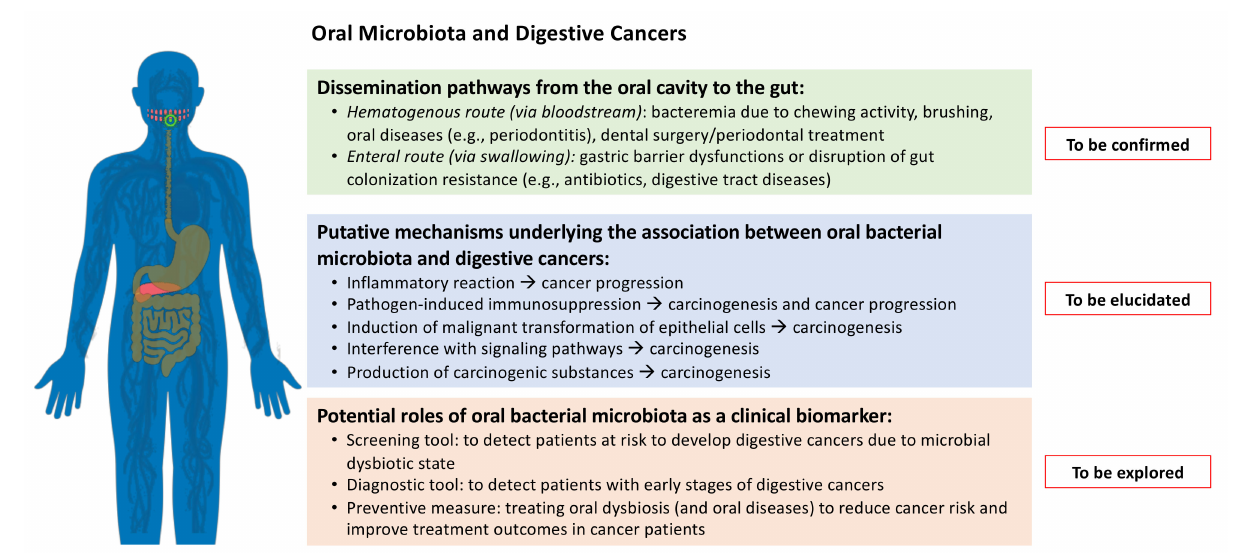
Figure 2. Schematic representation of the possible routes of oral bacteria transmigration from the oral cavity to the gut and the possible oral microbiota mechanisms in digestive cancers. The potential role of oral bacterial microbiota characterization for the screening and risk assessment of some types of digestive cancer is also